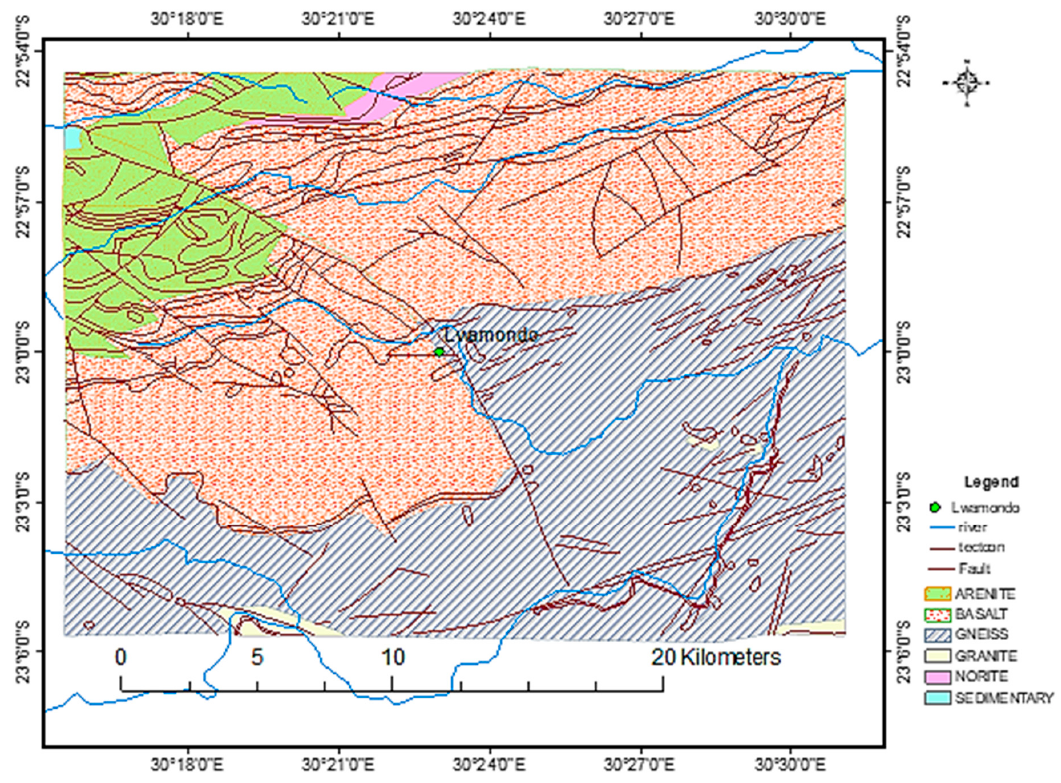
Figure 1. Geological setting of the Lwamondo kaolin occurrence. Modified from [18].